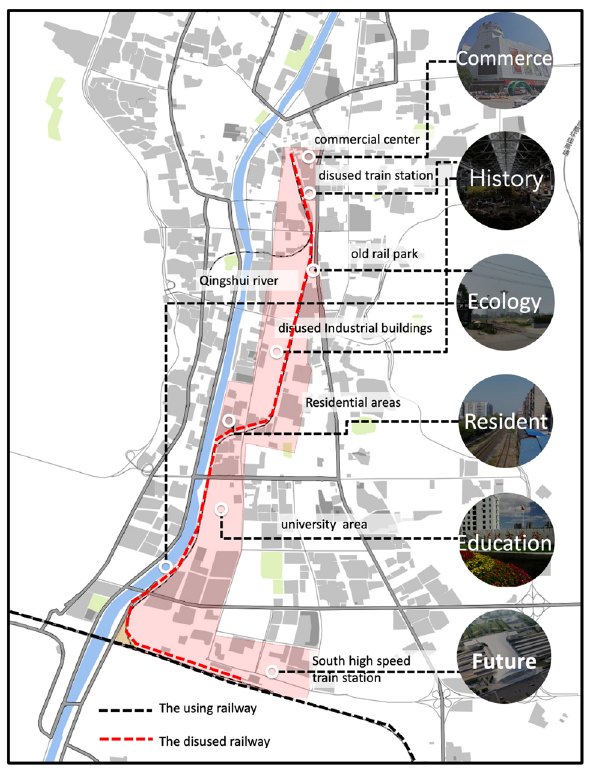
Fig. 5 Resources along the abandoned railway. Source : Drawn by the authors